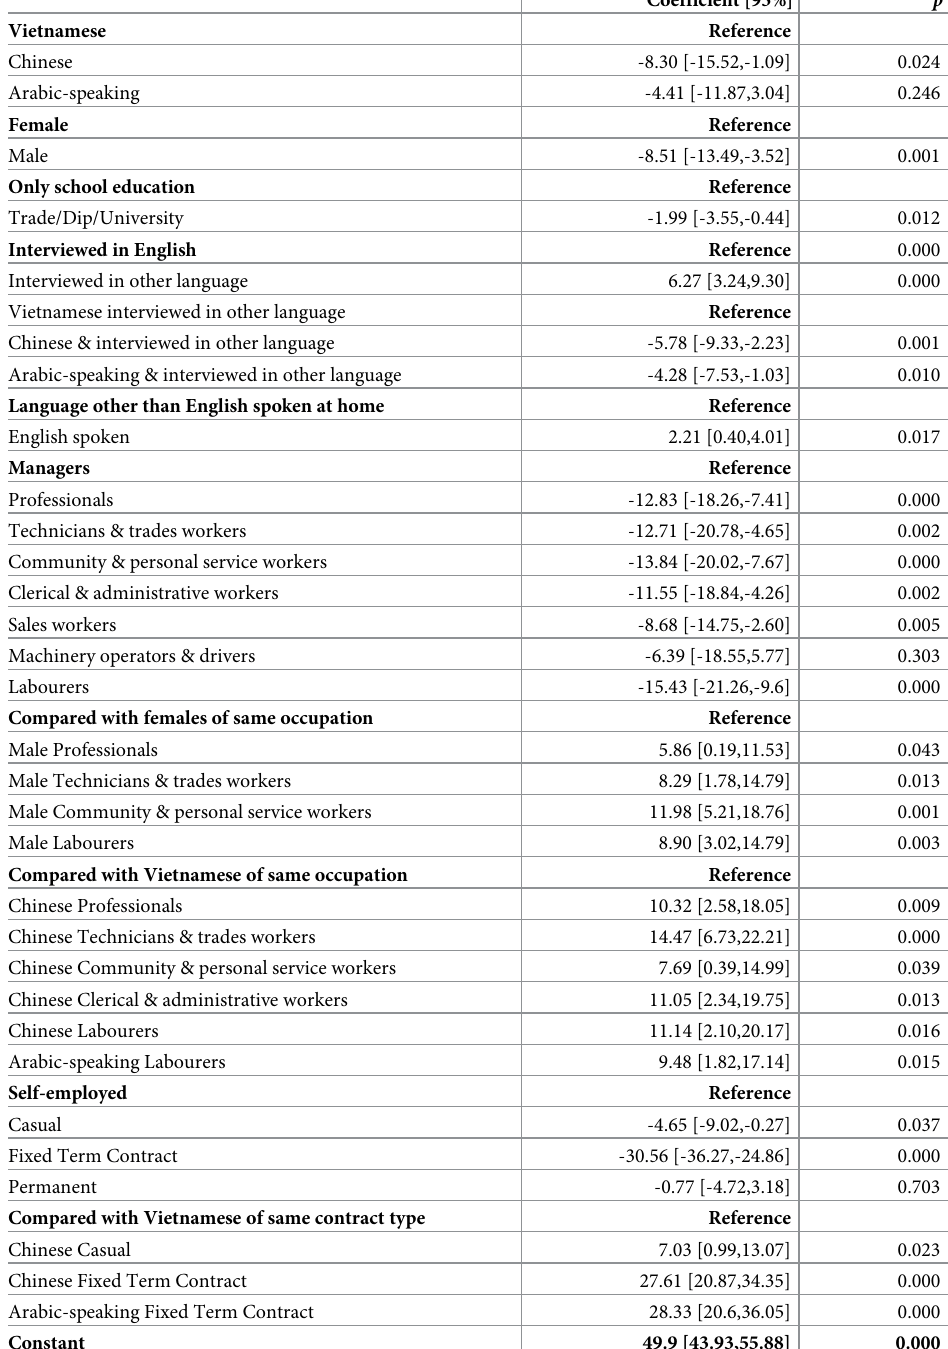
Table 3. Psychosocial job quality (the summed scale of high demand, low control and low security ratings) with socio demographic and employment associations among migrant workers with significant